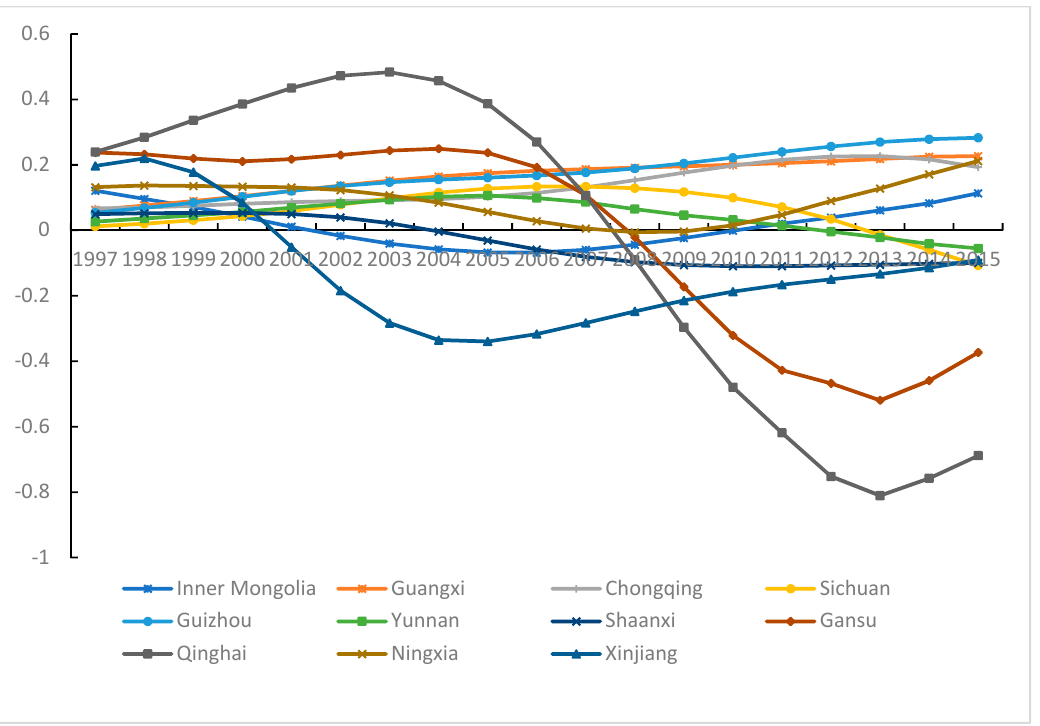
Figure 11. Parameter estimates of industrial pollution emissions in Western China.